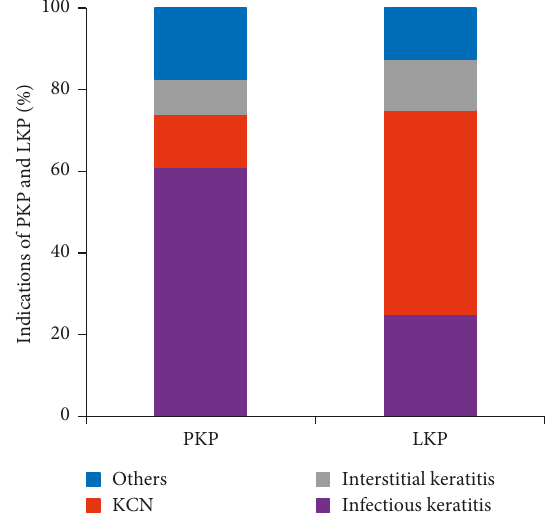
Figure 2: The indications of PK and LK.